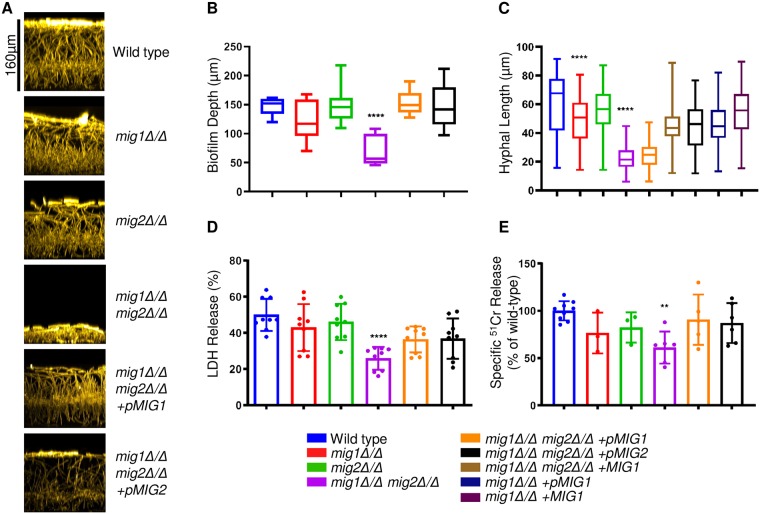
Mig1/2 promote filamentation, biofilm formation, and affect host cell interactions in vitro.A. Biofilms were grown for 24 h on silicone squares in RPMI media at 37°C. Fixed biofilms were stained with Concanavalin A Alexa Fluor 594. Representative side-view projections were processed and pseudocolored using ImageJ. Scale bar corresponds to depth of the wild-type B. Biofilms were measured using confocal microscopy. Values shown are triplicate measurements from three biological replicates. ****, p<0.0001. C. Indicated strains were grown for 4 h in RPMI at 37°C. Fixed cells were imaged using DIC microscopy and a 20x objective. Hyphal lengths were measured from yeast cell to hyphal tip from >80 cells from 10 fields of view. ****, p<0.0001 D. J774.1 macrophage cytotoxicity was measured by lactate dehydrogenase release (LDH) after 5 h of coincubation with C. albicans strains as indicated. Percentage of LDH release was calculated relative to max release wells containing lysis solution. Values shown are mean with SD from duplicate measurements of three biological replicates. ****, p<0.0001. E. Human endothelial cell damage was assessed by 51Cr release following coincubation with C. albicans cells for 3 h. Percentage of Chromium release was calculated by comparison to release from wild-type (release–spontaneous/total incorporation–spontaneous)**, p<0.01.